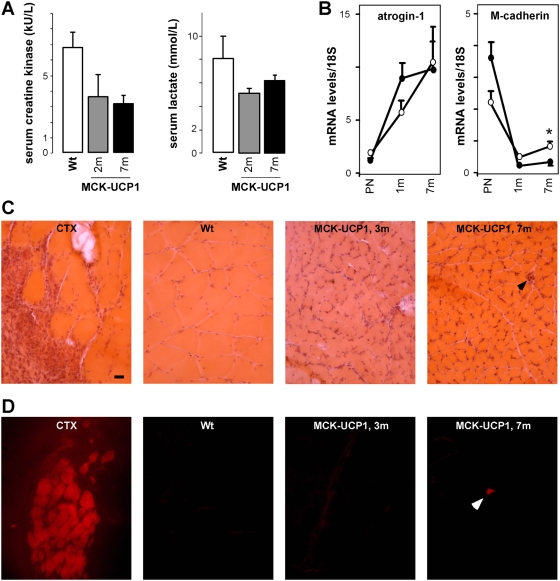
MCK-UCP1 do not display muscle dystrophy.A: serum creatine kinase (left panel) and lactate (right panel) concentrations in wild-type (Wt) or MCK-UCP1 mice at 2 months (2 m) and 7 months (7 m) of age. Non-significant differences (n = 8 mice per group). B: mRNA levels of atrogin-1 and M-cadherin in gastrocnemius from wild-type (empty circles) or MCK-UCP1 (black circles) mice at perinatal (PN), 1 month (1 m) and 7 months (7 m) of age. *, p<0.05 vs corresponding wild-type (n = 3–8 mice per group). C: representative photomicrographs showing hematoxylin and eosin staining of gastrocnemius from cardiotoxin-injured (48 hours after injury, CTX), wild-type (Wt) or MCK-UCP1 mice at 3 months (3 m) and 7 months (7 m) of age. Three mice per group were analyzed. A necrotic myofiber is indicated by an arrow. D: Evans blue dye staining as visualised by fluorescence in gastrocnemius from cardiotoxin-injured (48 hours after injury, CTX), wild-type (Wt) and MCK-UCP1 mice at 3 months (3 m) and 7 months (7 m) of age. Three mice per group were analyzed. Only a few necrotic myofibers could be detected in 7-month-old MCK-UCP1 mice (arrow).